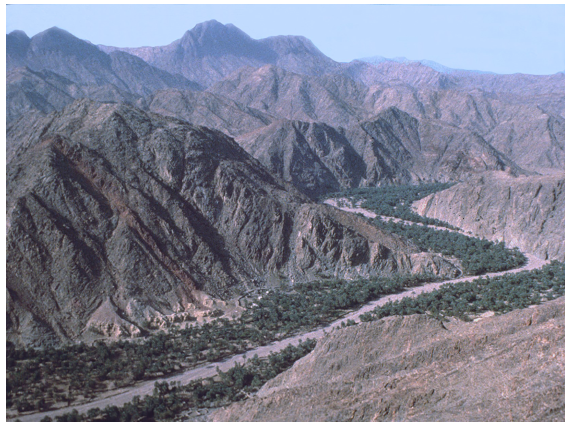
Figure 13 Part of the Feiran Oasis, view from Jebel